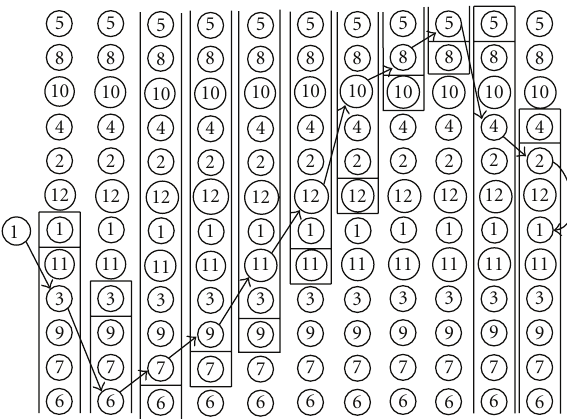
Figure 2: Arrangement of gathered EEoFoV points based on X and Y coordinate sorting.